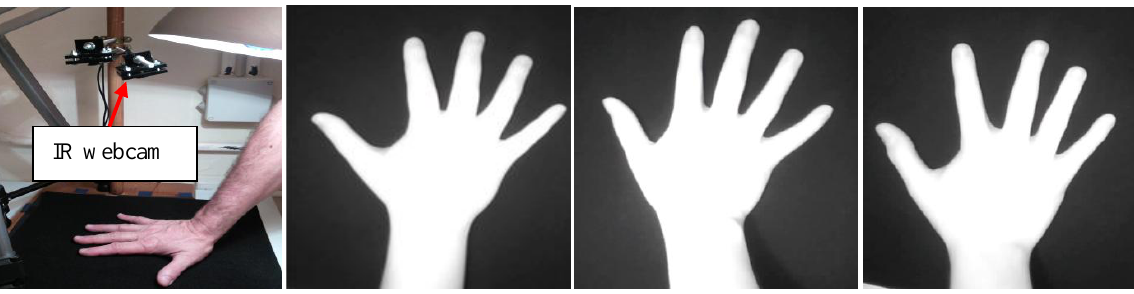
Figure 3. Hand dorsum infrared acquisition system (figure on the left) and examples of acquired IR hand images from different users (three figures on the